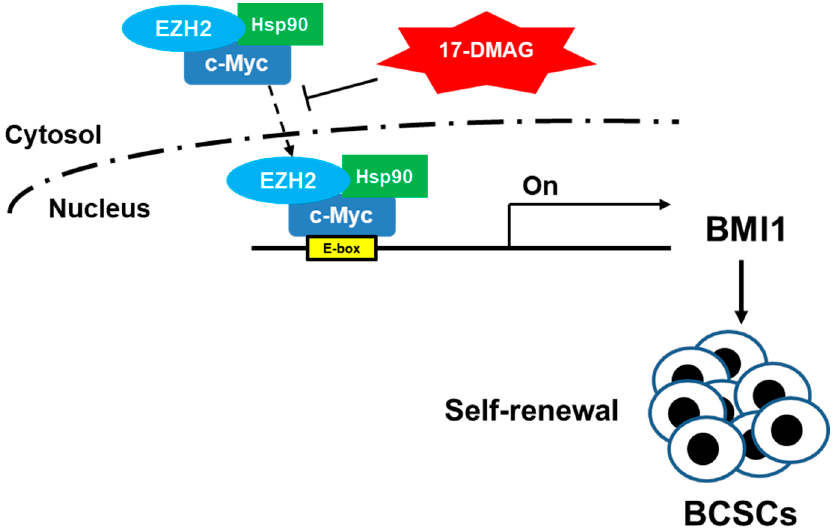
Figure 6. The working hypothesis of Hsp90-mediated BMI1 expression in BCSCs through the EZH2 and c-Myc pathways. One of the functions of Hsp90 α is to facilitate the nuclear translocation of EZH2 and c-Myc and binding to the E-Box region of the BMI1 promoter to drive BMI1 expression and regulates the self-renewal of BCSCs. The Hsp90 α mediated BMI1 expression could be inhibited by 17-DMAG, a specific Hsp90 inhibitor, which binds to ATP-binding pocket of the Hsp90 dimer.